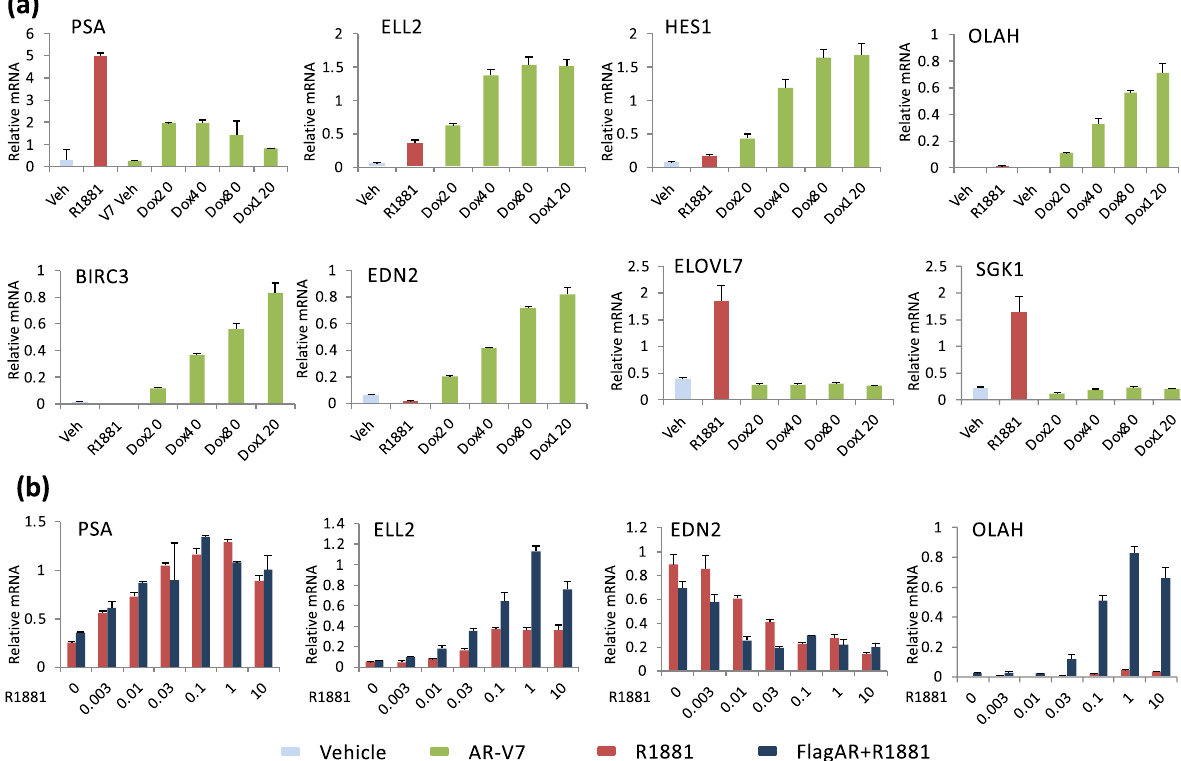
Figure 5. AR isoform concentration alters responsiveness for a sub-set of target genes. ( a ) LNCaP AR-V7 cells in 10% CSS were treated with vehicle (0.1% ethanol), 10 nM R1881 or varying levels of Dox (20–120 ng/mL) for 24 h prior to isolation of RNA and measurement of target genes by qPCR. Gene expression of AR and AR-V7 induced genes (PSA, ELL2, HES1), AR specific genes (ELOVL7, SGK1) and AR-V7 specific genes (EDN2, OLAH, BIRC3) was quantified using qPCR assays. ( b ) Cells were treated with vehicle or Dox (20 ng/mL) to induce FlagAR and the indicated concentration of R1881 (0–10 nM) for 24 h, RNA isolated and gene expression of AR and AR-V7 induced genes (PSA, ELL2) and AR-V7 specific genes (EDN2, OLAH) was quantified using qPCR assays. All qPCR plots are expression values normalized to 18S on the y -axis and corresponding treatment on the x -axis. Data are plotted as the mean of three biological replicates from the same experiment; error bars are SEM. Each experiment was performed a minimum of three times and a representative experiment is